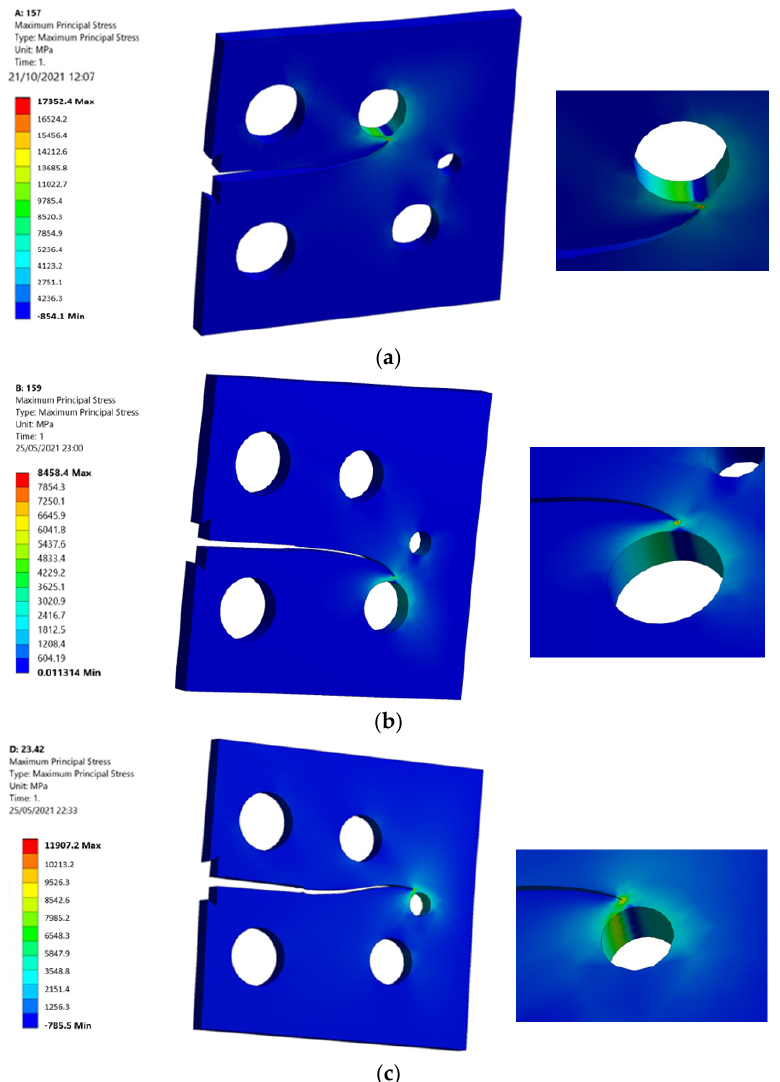
Figure 8. Maximum principal stress of ( a ) specimen 1, ( b ) specimen 2, and ( c ) specimen 3. The results of the opening mode of SIF ( K I ) for the three samples are shown in Figure 9. The maximum values of K I are 1205 MPa mm 0.5 , 4136 MPa mm 0.5 , and 5800 MPa mm 0.5 for a crack length of 12.97, 18.33 mm, and 21.161 mm for specimens one, two, and three, respectively. Similarly, Figure 10 also displays the estimated values for the second mode of stress intensity factor ( K II ). As the crack follows a curving trajectory toward the top hole, the K II values for the first specimen increase to a maximum of 96.133 MPa mm 0.5 at the boundary of the hole. However, in specimens two and three, the values of K II decreased with negative values as the crack propagated on a curved path in the opposite direction of specimen one, with minimum values of − 243 MPa mm 0.5 and − 230 MPa mm 0.5 for speci- mens two and three, respectively. In the mixed-mode situations, the direction of the tan- gential component of the applied load is attributed to the negative mode II stress intensity factor. The signs of SIFs depend on the orientation of the crack with the loading.